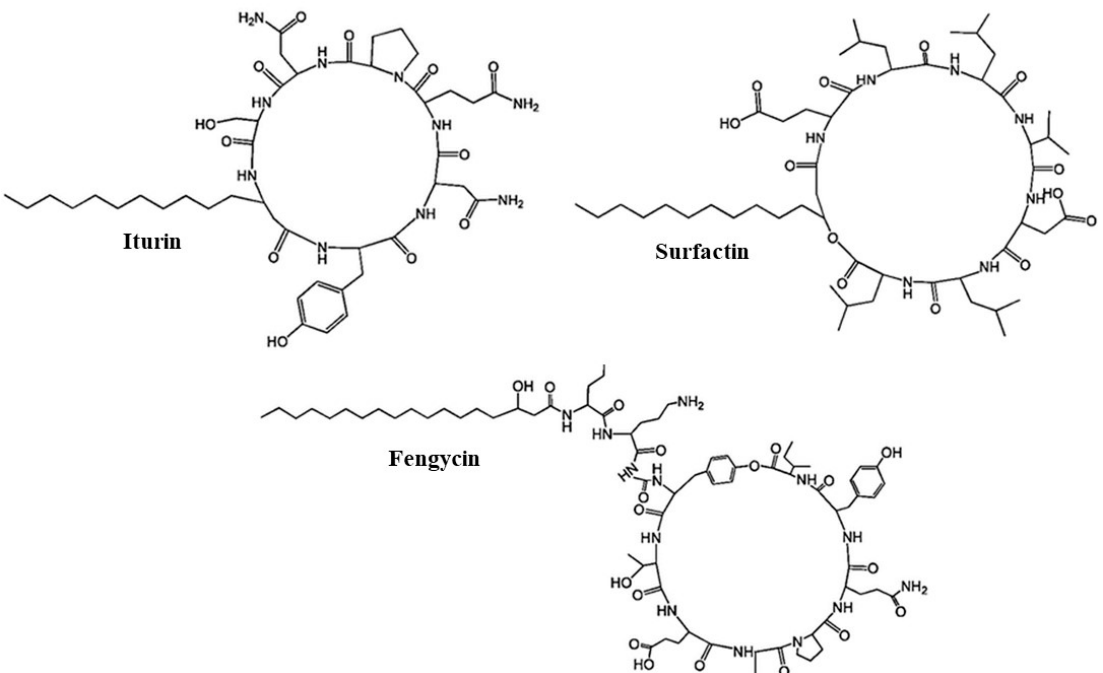
Figure 2. The structures of iturin, surfactin, and fengycin; all share a common structure consisting of a lipid tail linked to a short cyclic peptide. The derivatives of compounds in each group come from different amino acid components [85].